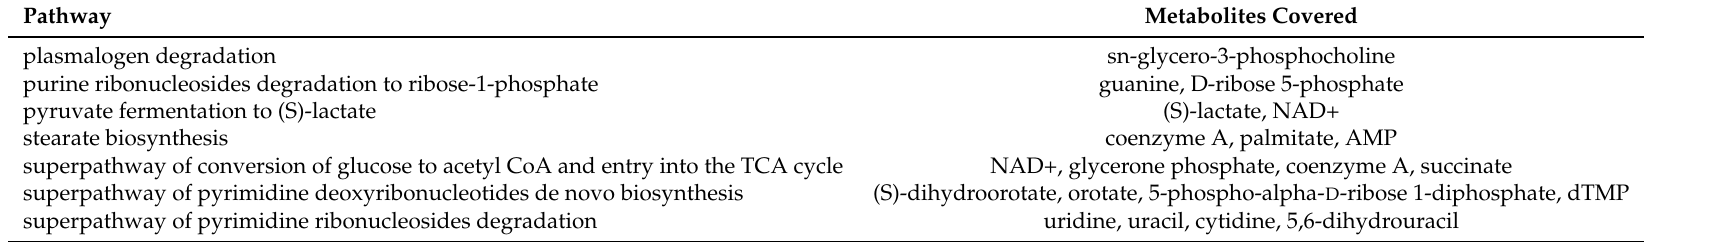
Table A10. McDonnell 2013, Pathway Covering Using Constant Cost Function.